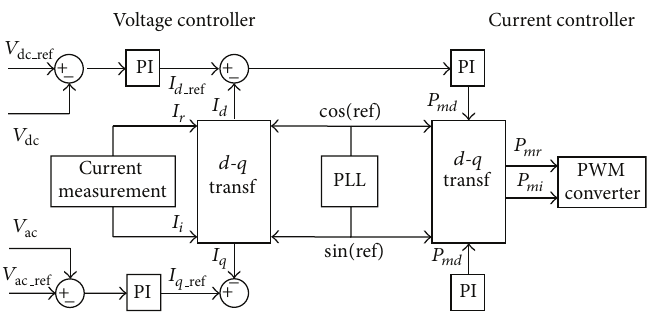
Figure 5: Control block diagram of the grid side converter.